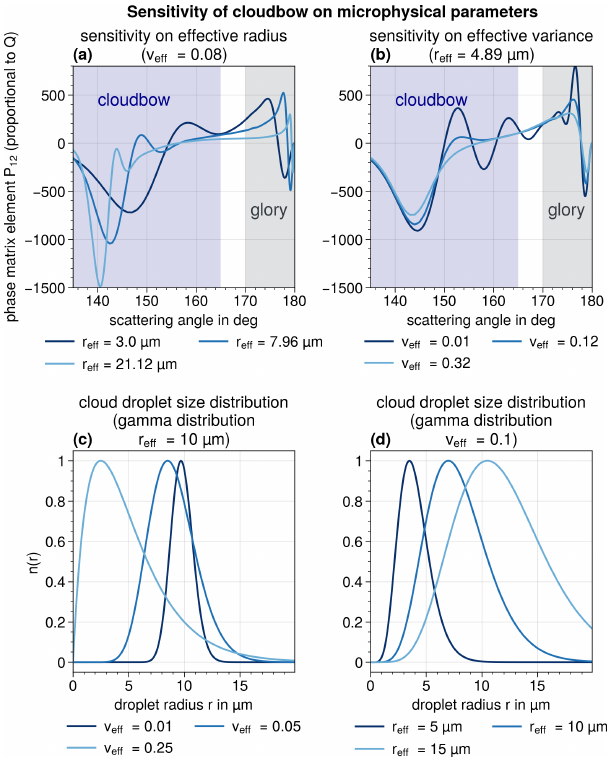
Figure 5. Panel (a) shows that the cloudbow signals ( P 12 ) vary if the r eff is changed while the v eff is constant ( v eff = 0 . 08). Panel (b) illustrates the effect of a change in the v eff while the r eff is held con- stant ( r eff = 4 . 89µm). For calculating P 12 , we assume that the DSD has the shape of a gamma distribution. The P 12 curves shown here are for the green channel of the specMACS cameras. In panels (c) and (d) , several gamma distributions for different v eff and a con- stant r eff = 10µm (c) and for different r eff and a constant v eff = 0 . 1 (d) are